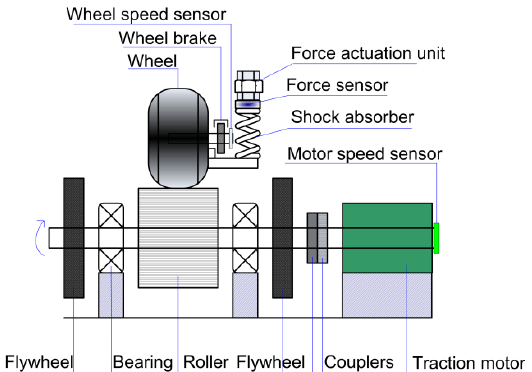
Figure 2. Schematic design of testing rig.